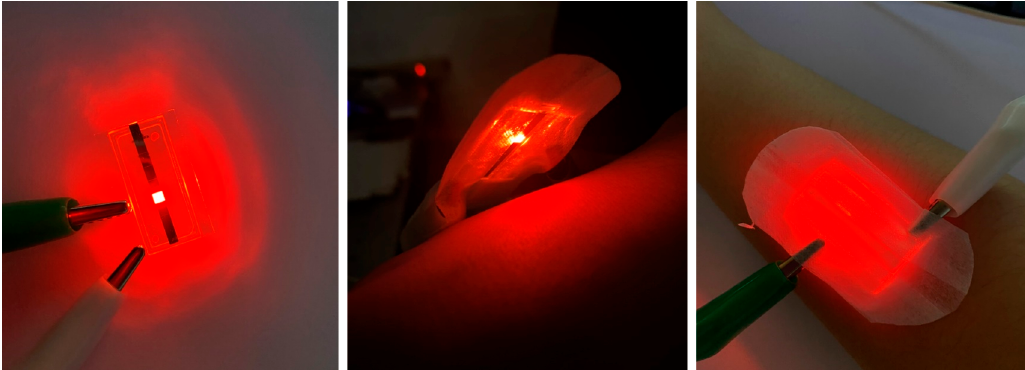
Figure 7. Schematic images of the PBM patch.